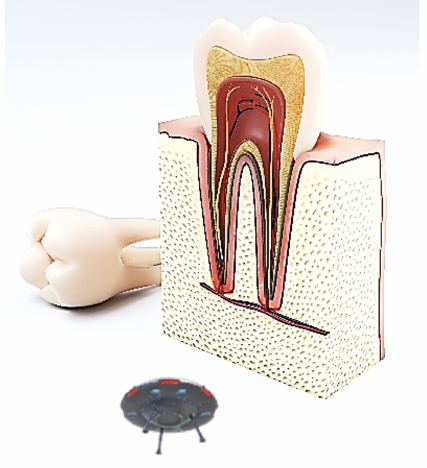
Figure 7. Nanorobots in dentistry for the treatment of hypersensitivity.